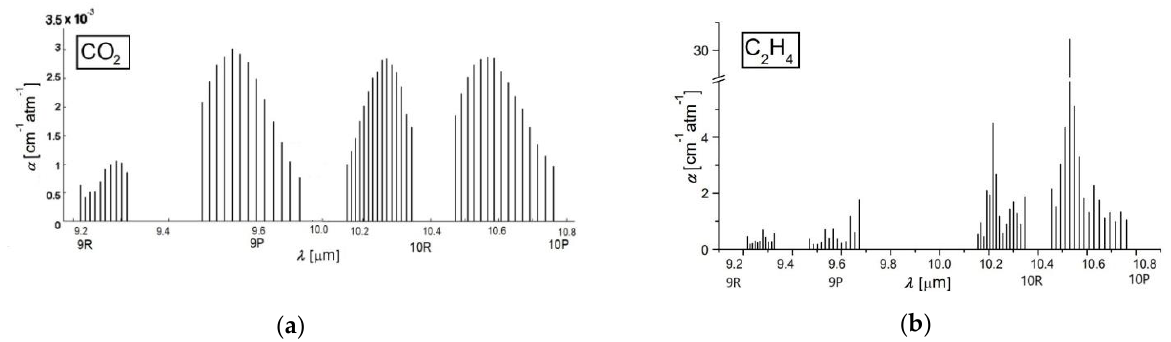
Figure 1. The absorption coefficients at laser lines of ( a ) carbon dioxide and ( b ) ethylene [32,33].